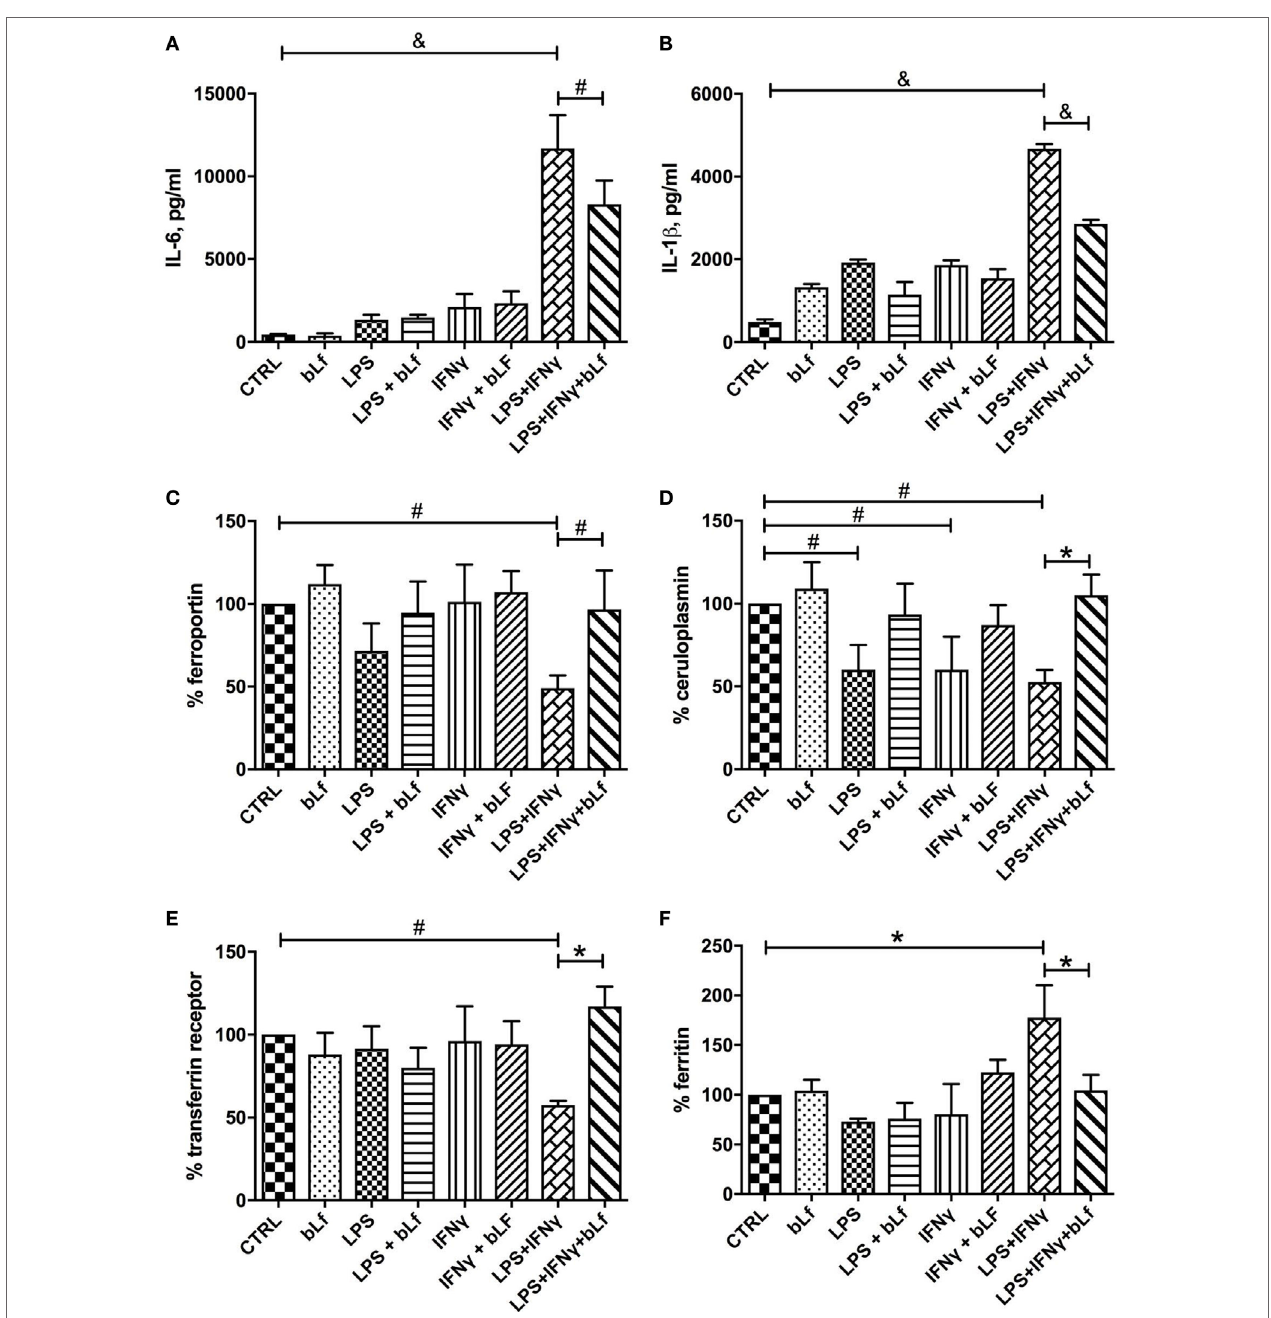
FigUre 2 | Changes in IL-6 (a) , IL-1 β (B) , ferroportin (c) , membrane-bound ceruloplasmin (D) , transferrin receptor 1 (e) , and cytosolic ferritin (F) levels in THP-1 cells stimulated with a mixture of 20 ng/ml IFN- γ and 10 pg/ml LPS, in the presence or absence of 100 μg/ml bLf. # p < 0.05; * p < 0.01; & p <